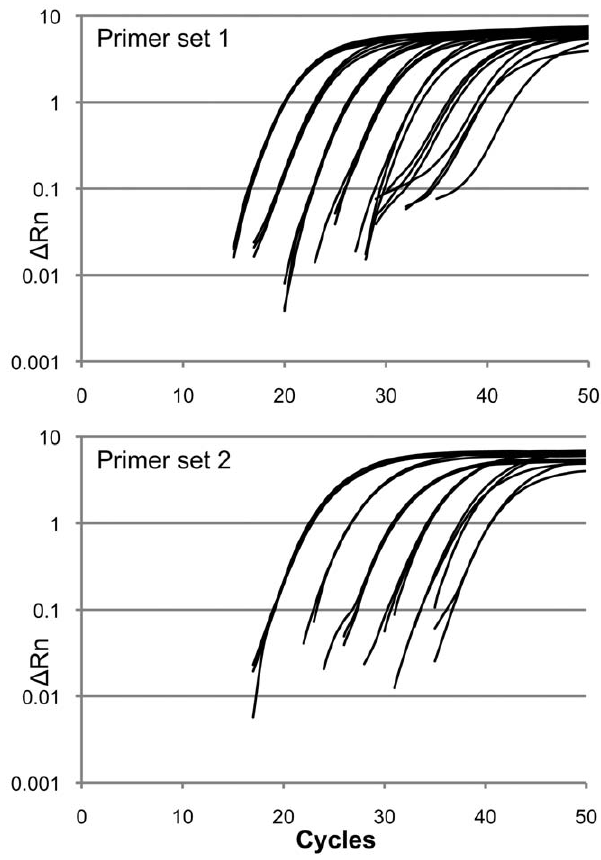
Figure 2. Detection of TaqMan positive controls used for HIV- 1-positive leukocyte DNA sample screening. TaqMan PCR curves are shown for amplification of serial 10-fold dilutions of positive control DNA (A) Curves represent the triplicate amplification of dilutions of